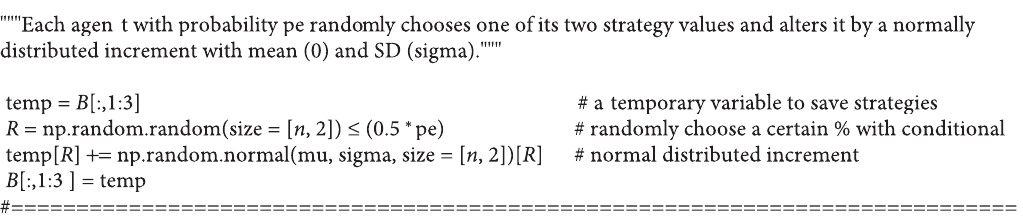
Figure 13: Code book: